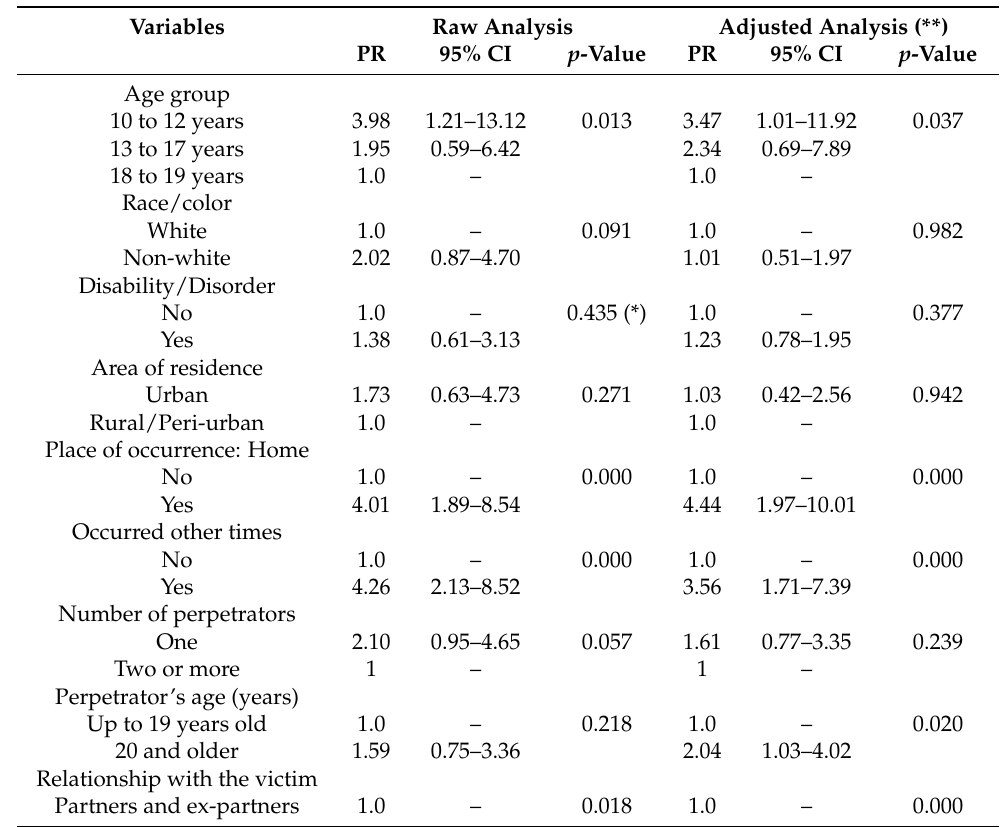
Table 4. Crude and adjusted analysis of the effects of the characteristics of cases of sexual violence against male adolescents. Esp í rito Santo, Brazil,